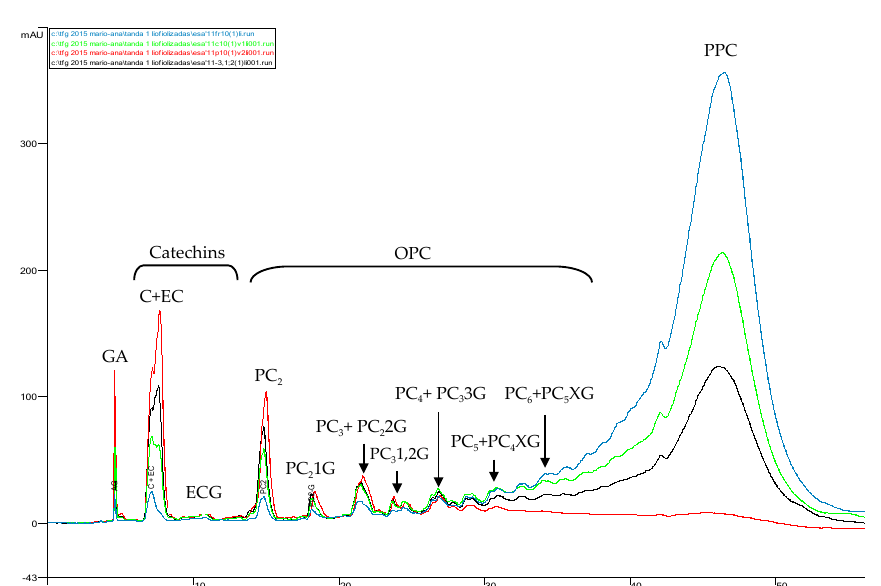
Figure 5. Overlay of the NP–HPLC-PAD chromatograms (280 nm) of the initial (clarified) grape seed extract (GSE; black), the whole permeate (red), the concentrate (green) and the diafiltered concentrate (blue) after GSE fractionation by the 10-kDa MMCO membrane (data refer to one replicate). GA—gallic acid, C + EC—catechin and epicatechin, ECG—epicatechin gallate, PC 2 to PC 6 —procyanidin dimers to hexamers, PC 2 1G—monogaloylated procyanidin dimer, PC 2 2G—digaloylated procyanidin dimer, PC 3 1,2G—mono- and digaloylated procyanidin trimers, PC 3 3G—trigaloylated procyanidin trimer, PC 4 XG and PC 5 XG—multigaloylated procyanidin tetramers and pentamers, OPC—oligomeric procyanidins, PPC—polymeric procyanidins.